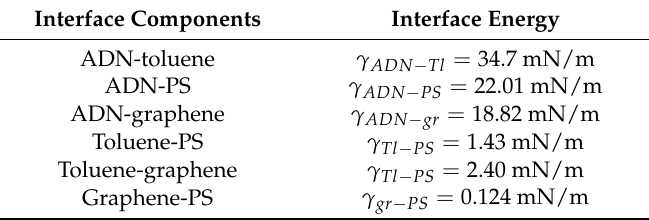
Table 2. Interface energy of different components calculated using Equation